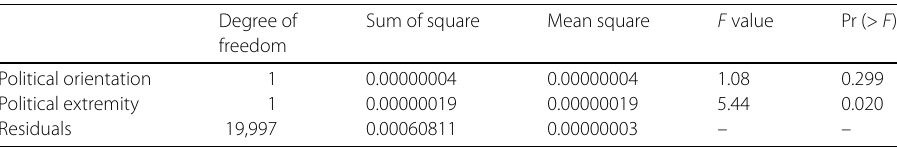
Table 7 Multi-group mean comparisons of certainty using Tukey’s HSD test Mean 95% Confidence interval Adjusted difference P-valueLower Upper bound bound lwe-lw –0.0004 –0.0012 0.0004 0.5723 rw-lw 0.0003 –0.0005 0.0011 0.7805 rwe-lw –0.0003 –0.0011 0.0005 0.835 rw-lwe 0.0007 –0.0001 0.0015 0.1112 rwe-lwe 0.0001 –0.0007 0.0009 0.9759 rwe-rw –0.0005 –0.0013 0.0002 0.2863